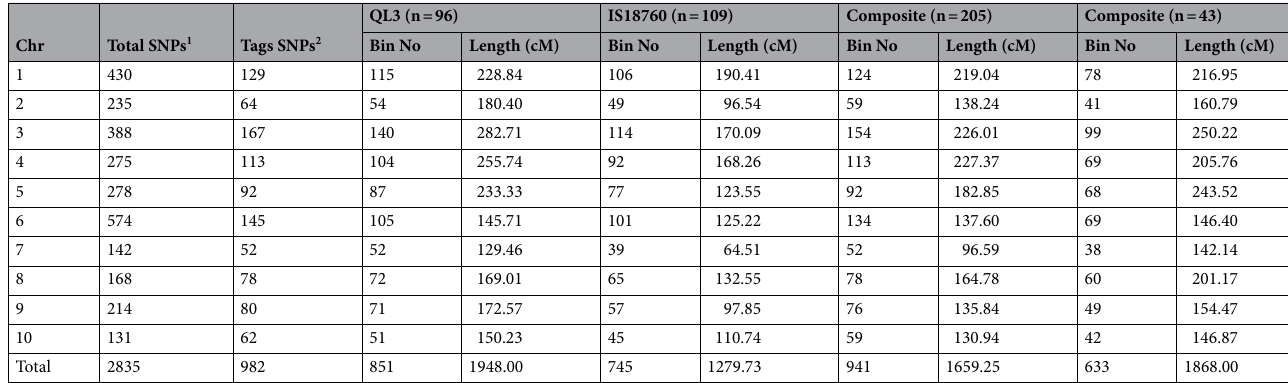
Table 2. Comparison of genetic linkage maps constructed with two recombinant inbred line (RIL) populations derived from the crosses between QL3 and IS18760 with a common parental line PI609251, and a composite linkage map for both populations and a subset of RILs selected based on recombination events (i.e. bin map). 1 Single nucleotide polymorphisms identified by the genotype-by-sequencing analysis of the RIL populations. 2 Single nucleotide polymorphisms selected for the construction of genetic linkage